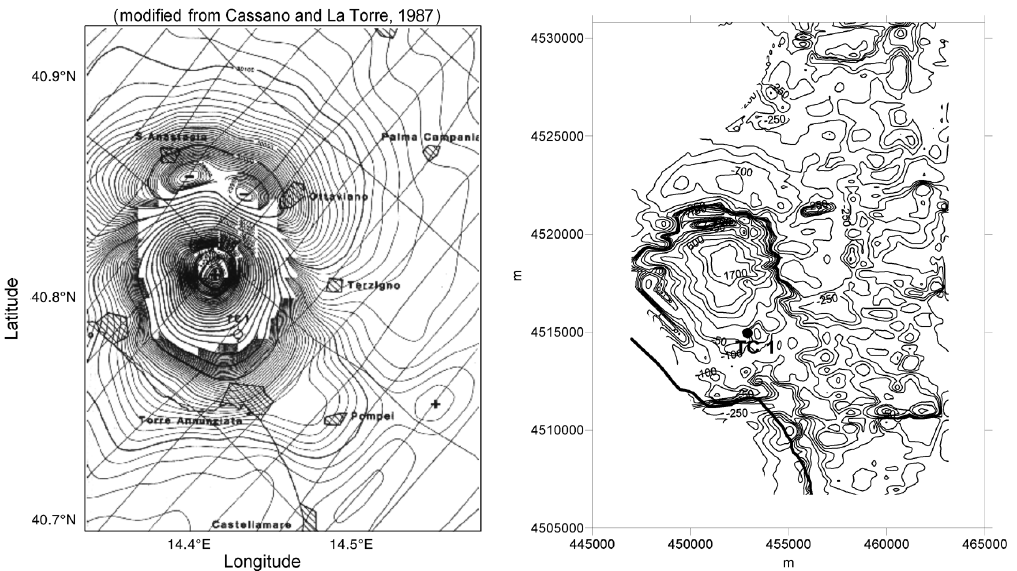
Fig. 4. Comparison between the aeromagnetic data set from 1999 ( right ) and the data acquired by Agip in 1981. The black dot in the right plot locates the Trecase1 well (TC